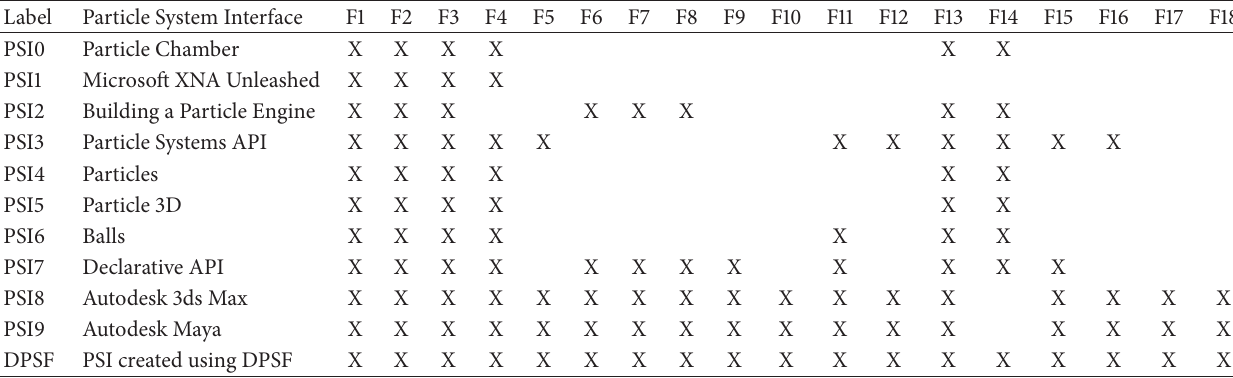
Table 1: A list of PSIs, a PSI created using DPSF, and the features from Section 3 that they